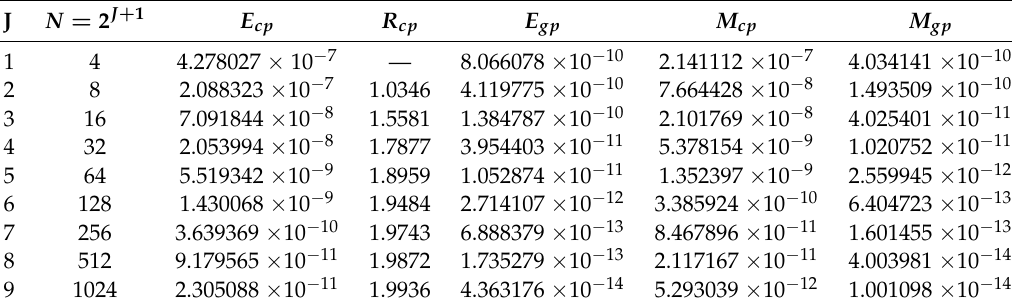
Figure 1. Comparison of numerical and analytical solution for 32 CPs of Problem 1. Table 1. E cp , R cp , E gp , M cp and M gp for Problem